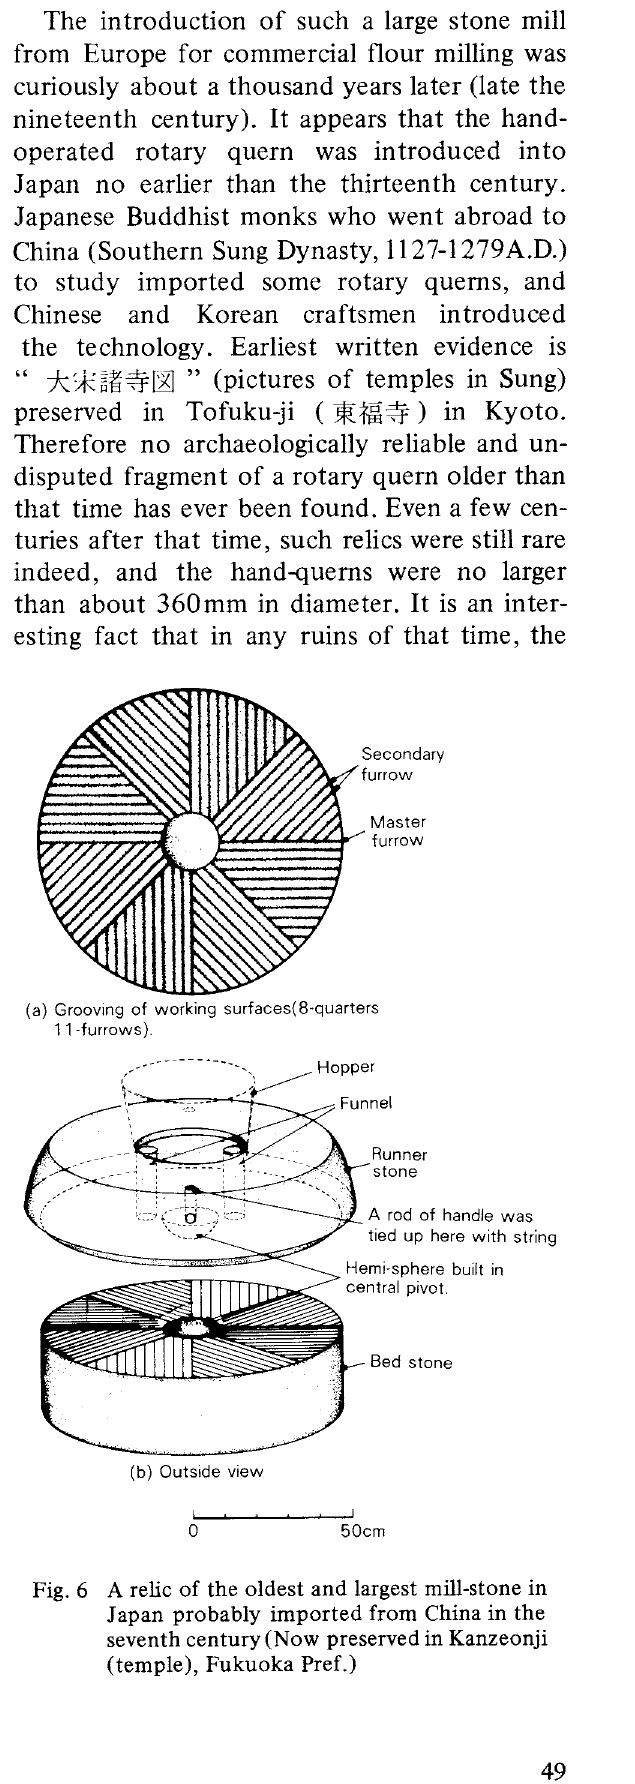
Fig. 6 A relic of the oldest and largest mill-stone in Japan probably imported from China in the seventh century (Now preserved in Kanzeonji (temple), Fukuoka